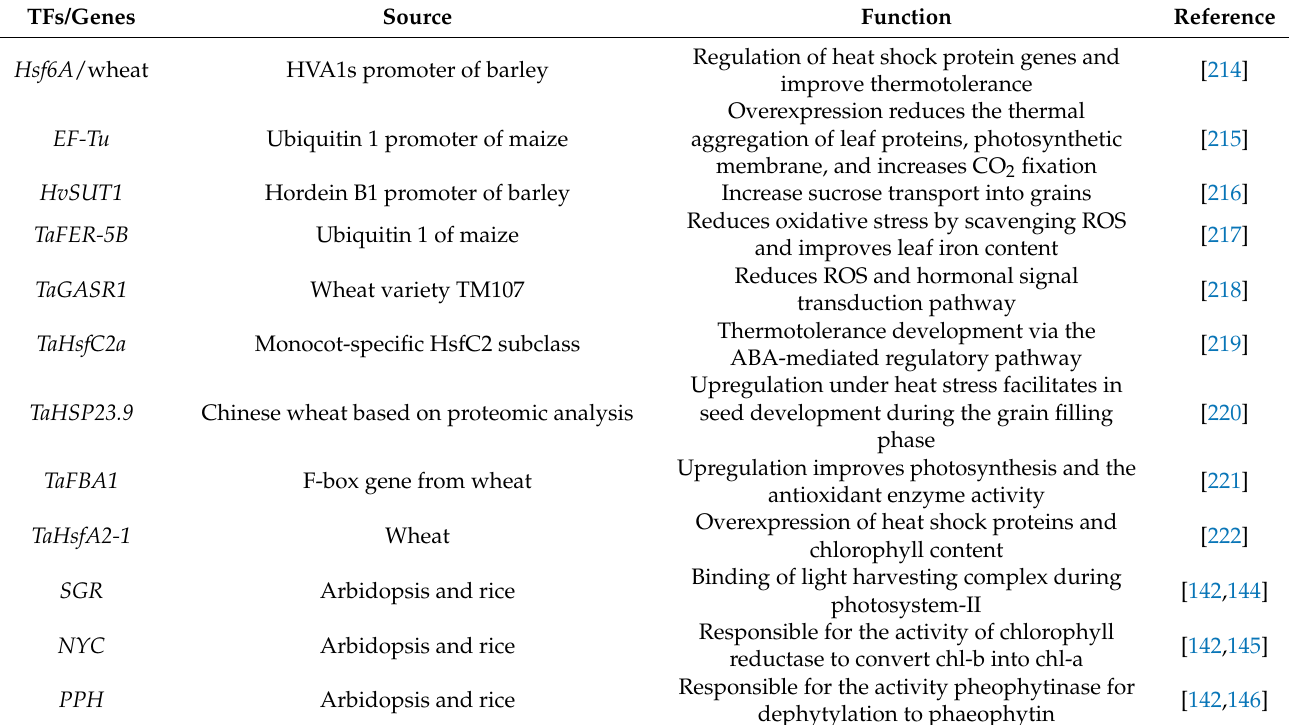
Table 3. List of genes encoding transcription factors related to thermotolerance.